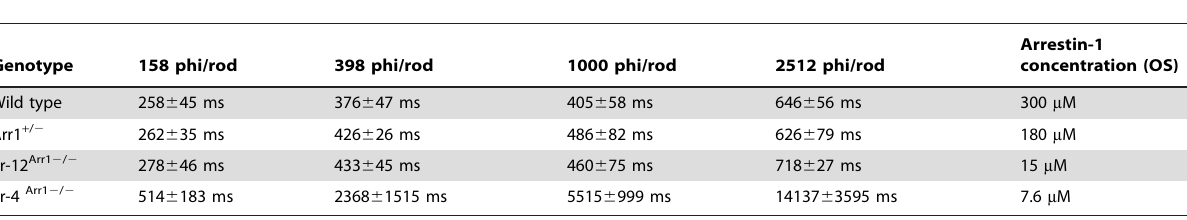
Table 1. The rates of photoresponse recovery in mice with different arrestin-1 expression.